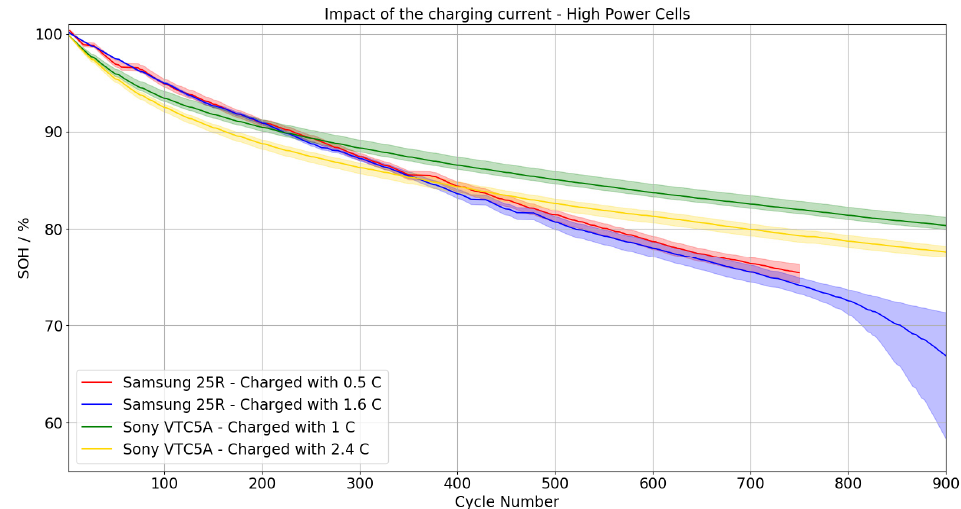
Figure 3. Development of the SOH during the cycle test of the high-power cells. Solid lines represent the mean values, shaded areas represent the spread of the measured values.